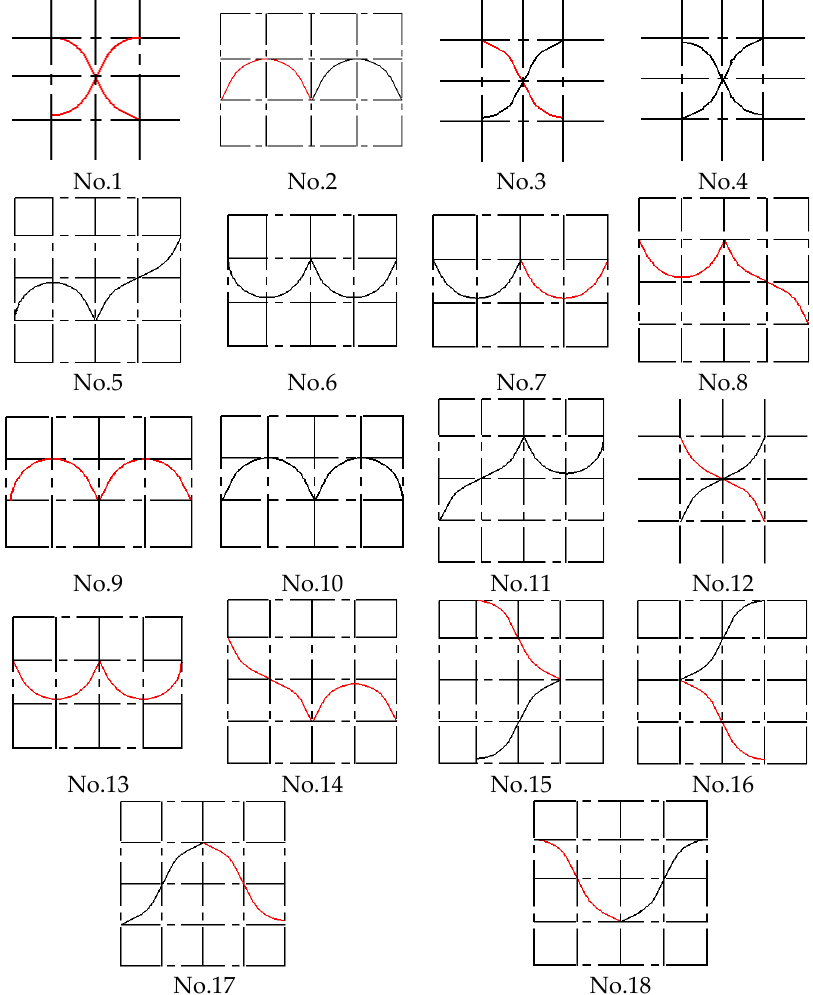
Figure 6. Intersecting relationship between two tracks in which carriers may collide.